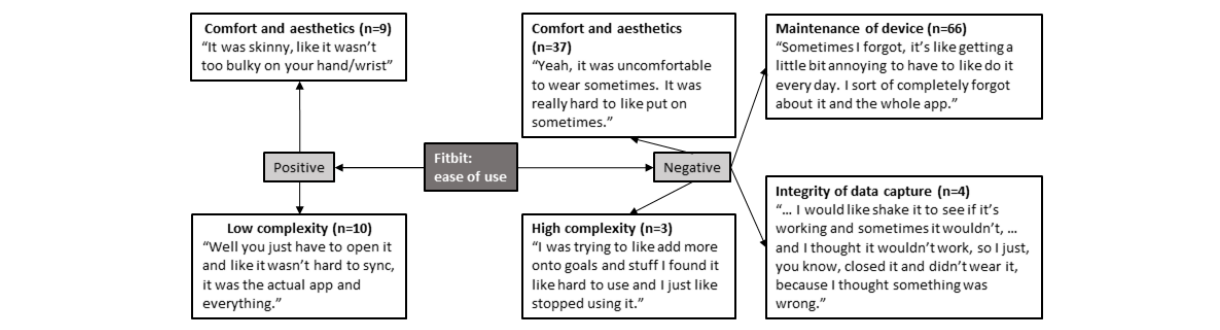
Figure 3. Perceived ease of use of Fitbit in adolescents. Note: n=number of times theme was mentioned by adolescents.